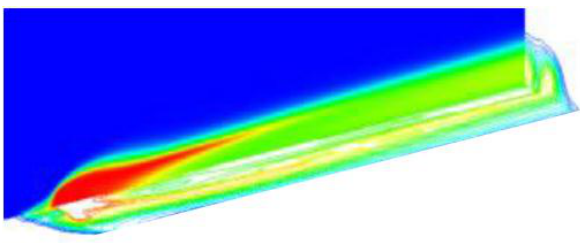
Figure 3. Transverse injection mixing study of H 2 reported in [1], red-to-blue denoting the percentage of H 2 species in the domain.